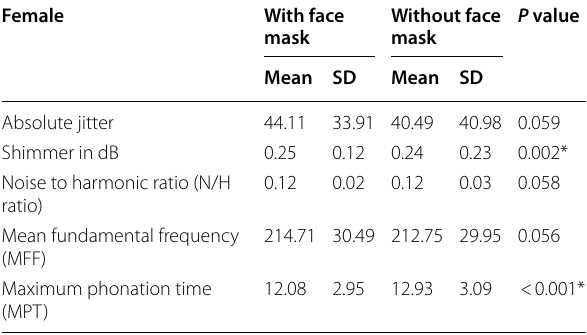
Table 8 Comparison between the measures of voice parameters with a face mask and without a face mask in female